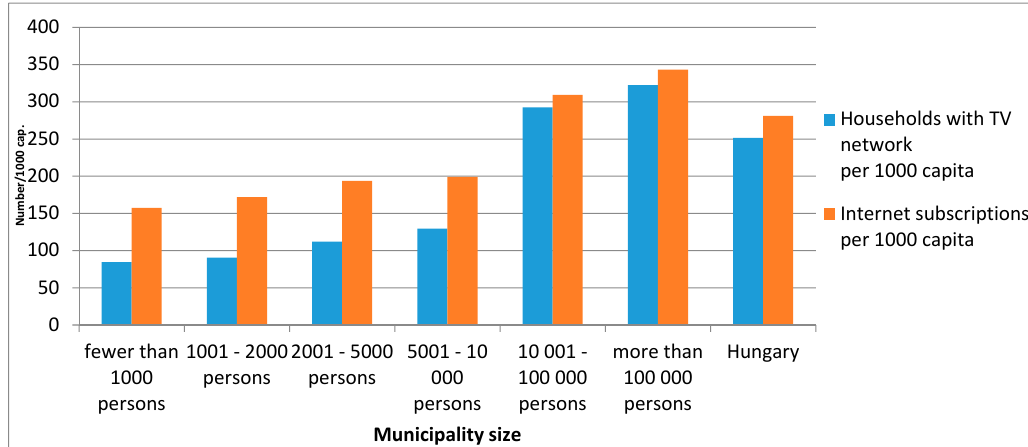
Figure 6. The number of households with television and Internet access per 1000 capita by population categories (authors’ edition based on KSH database).